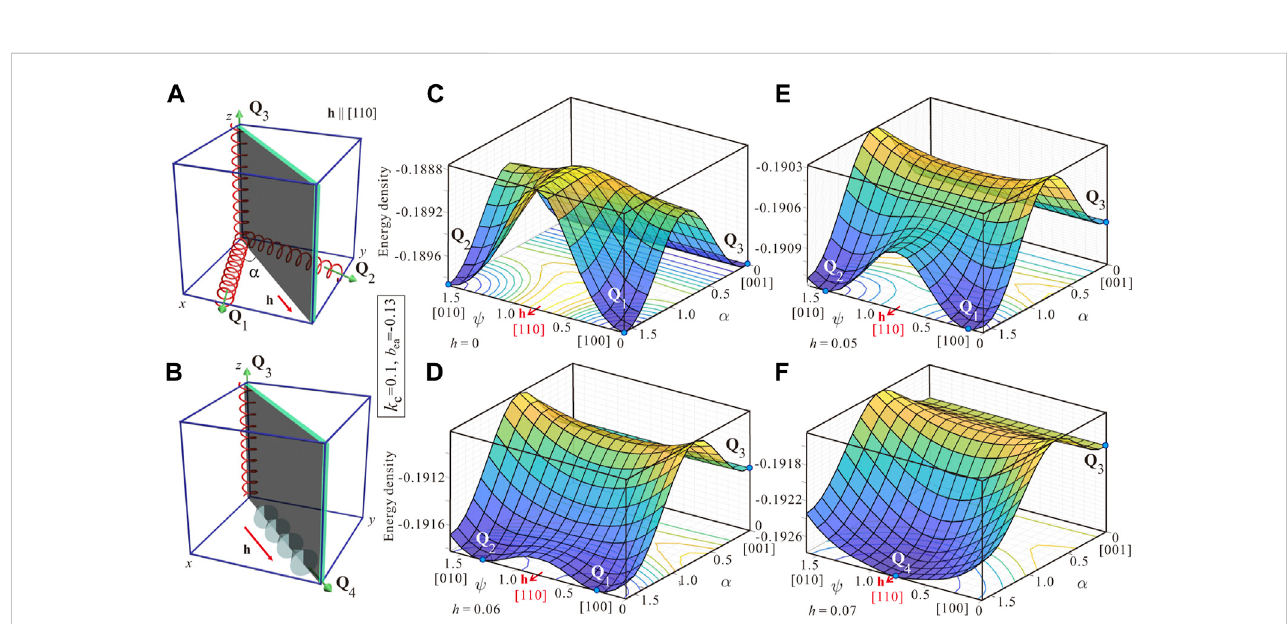
FIGURE 4 (color online) Spiral reorientation for H (cid:1) [110] and k c = 0.1, b ea = − 0.13. (A) The three spiral states in low magnetic fi elds. Under an applied magnetic fi eld, the oblique spiral states with Q 1 and Q 2 (along the [100] and [010] directions in zero fi eld, respectively) undergo a fi rst-order phase transition into the conical phasewith Q 4 (cid:1) H (B) ,whereas themetastabletransversalspiral with thewave vector Q 3 (cid:1) [001] persistsup toahigher magnetic fi eld. Such aspiral reorientation is characterized by the surface plots of the energy density (C – F) depending on the angles ψ and α as de fi ned in Figure